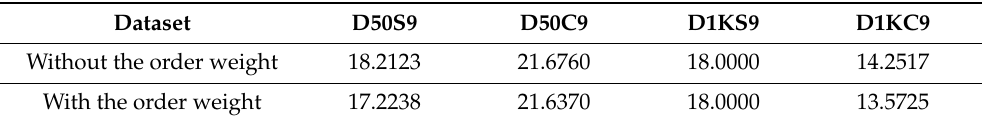
Table 3. Structure distances between the generating causal structure and the Dataset Global BDe Best Order.